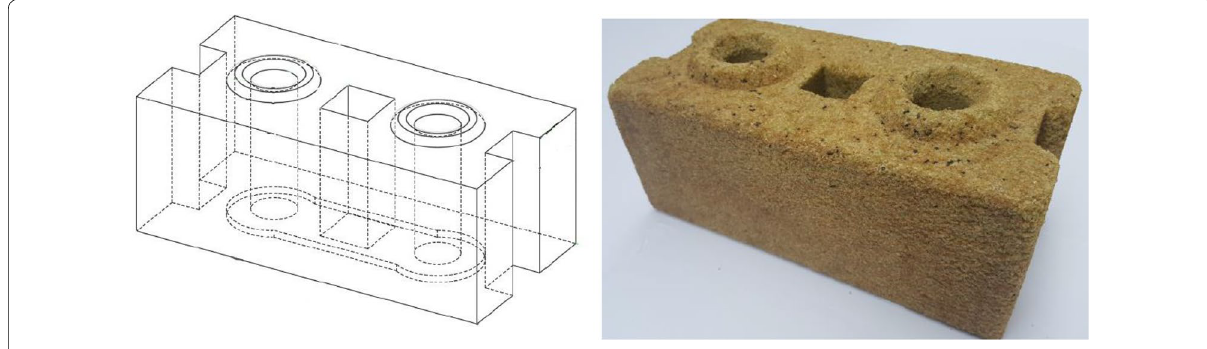
Fig. 3 Interlocking brick 3D view